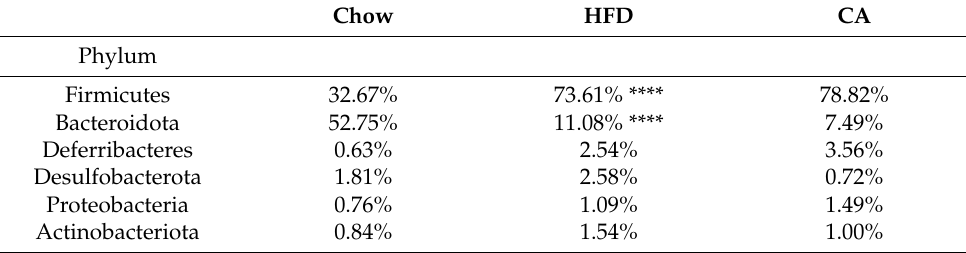
Table 5. The abundance of gut microbiota at the phylum level and family level.